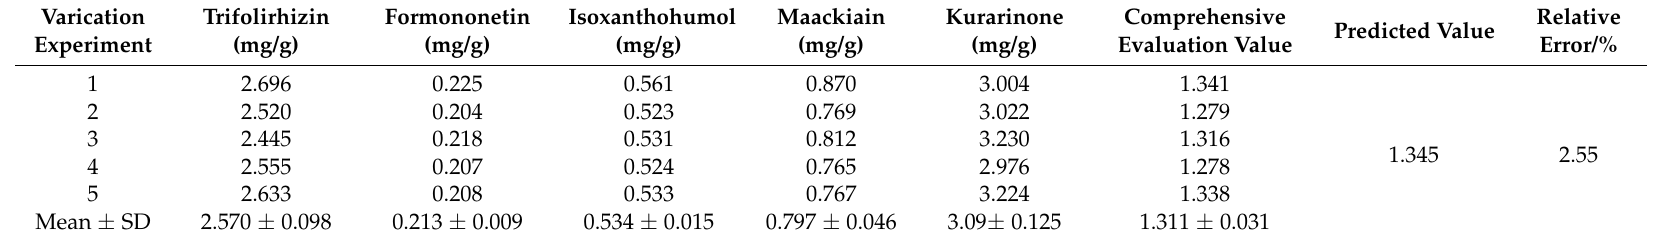
Table 2. Experimental data of the verification of predicted value at optimal extraction